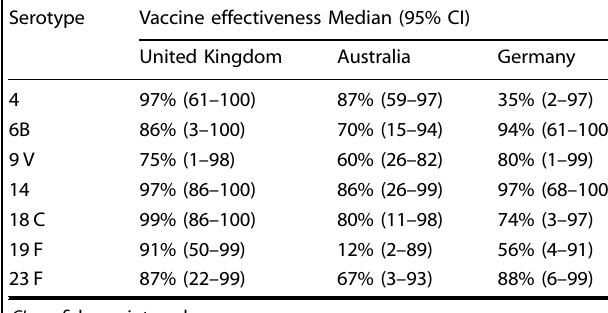
Table 2. Predicted serotype-speci fi c vaccine effectiveness for the PCV7 serotypes in PCV13.